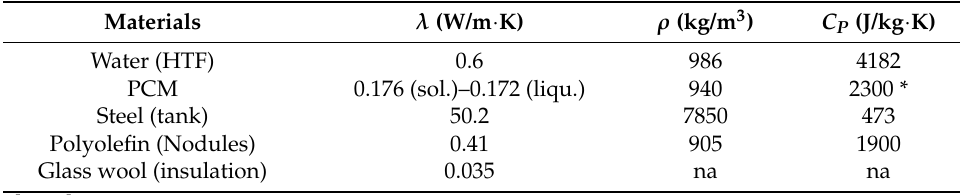
Table 3. Materials’ thermo-physical properties.